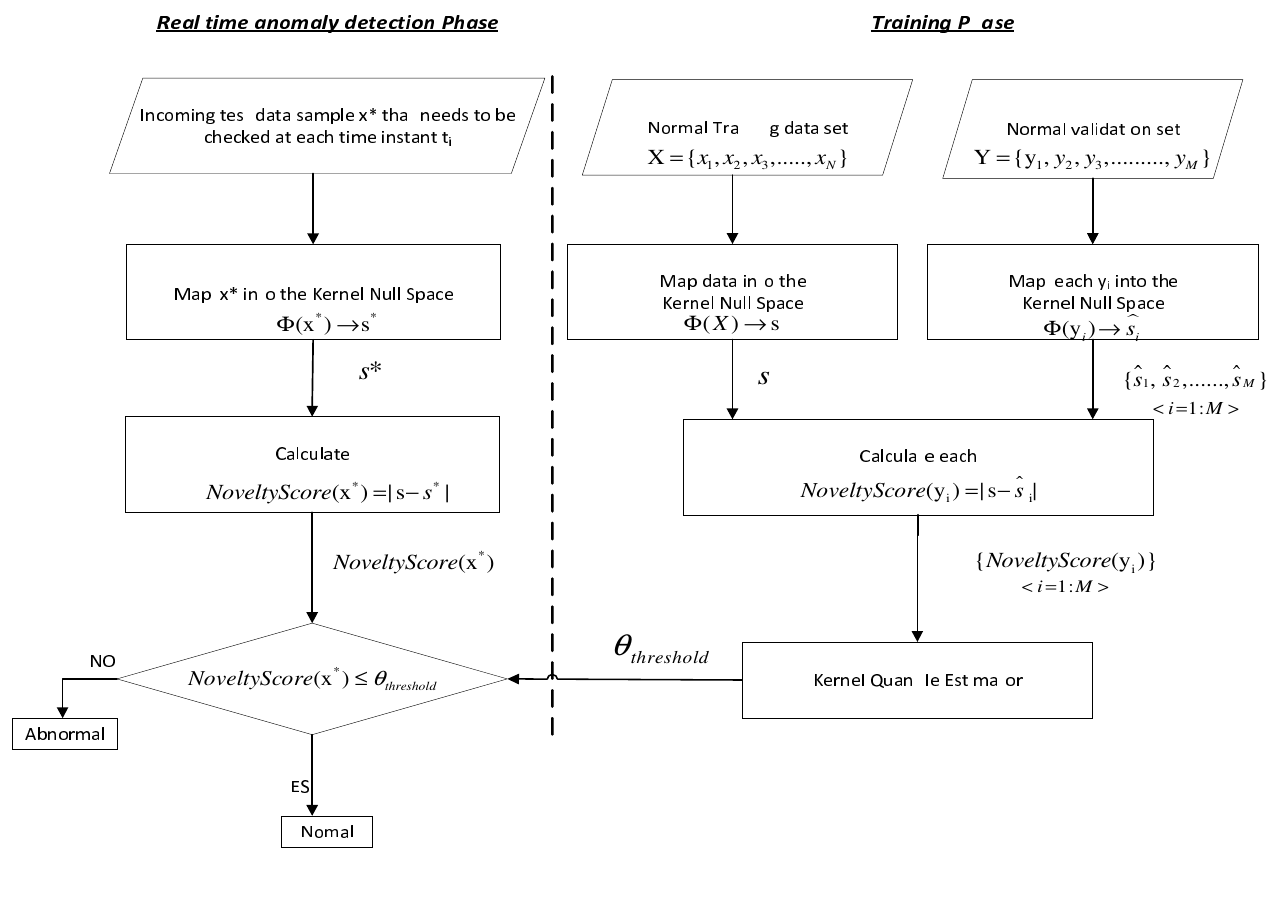
Figure 6. Detection procedure of EKNS